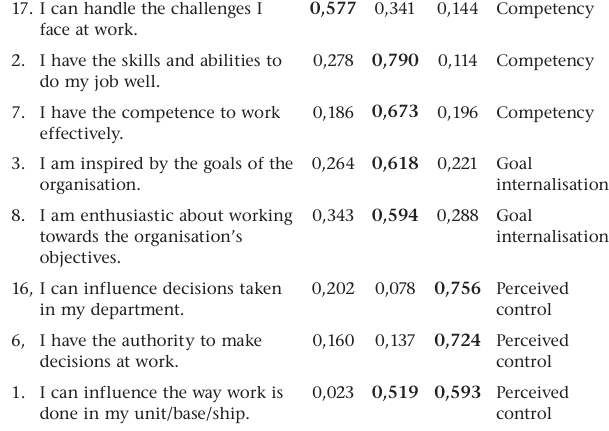
table 3 F actor analysis results For three Factors speciFied : a Fricans